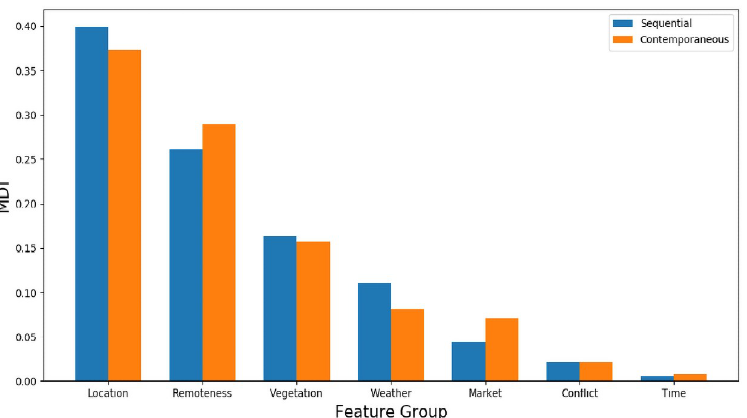
Fig 5. Mean MDI over all surveys, grouped by data type. Location refers to survey latitude, longitude, altitude, and slope. Remoteness indicates urban-rural status and distance to nearest major city. Vegetation includes pasture coverage, tree coverage, and SIF readings. Weather includes CHRPS and LST data. Market contains all food price data. MDI for each data type is computed by combining individual feature MDIs for each feature within that category.